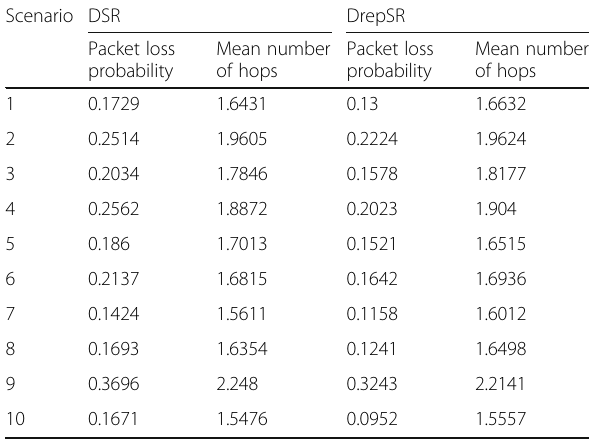
Table 2 Simulation